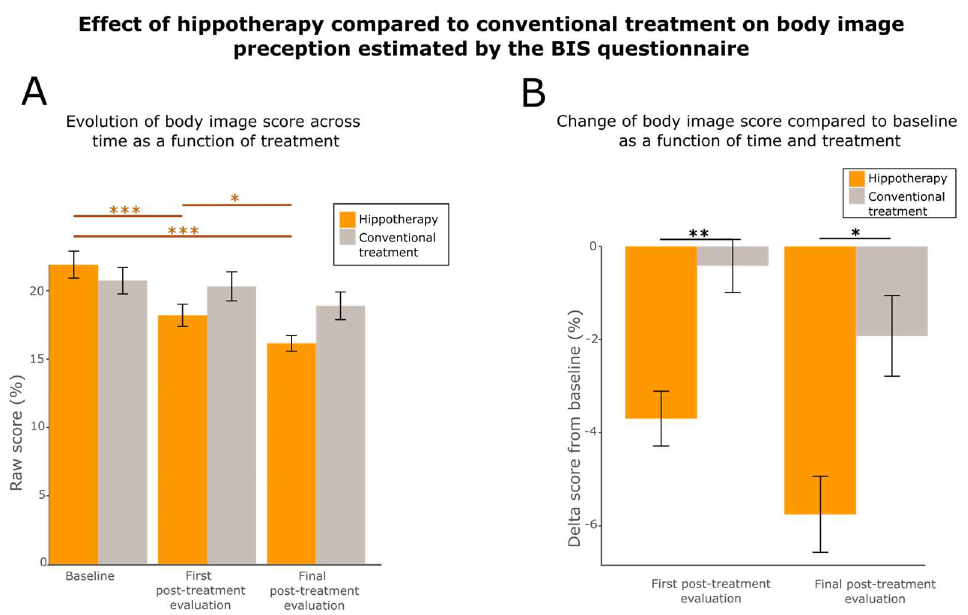
Figure 6. Effects of hippotherapy treatment compared to conventional treatment on body image per- ception, as estimated by the BIS questionnaire. ( A ) Bar chart represents means (M) and standard errors of means (SEM) for the evolution of body image score across time as a function of treatment’s type. Values (M ± SD) are as follows: Baseline = 21.9 ± 7.9, First post-treatment evaluation = 18.2 ± 6.41, Final post-treatment evaluation = 16.1 ± 4.65 for the hippotherapy group; Baseline = 20.7 ± 7.79, First post-treatment evaluation = 20.3 ± 8.48, Final post-treatment evaluation = 18.9 ± 8.04 for the control group. ( B ) Change in body image scores compared to baseline score (M ± SEM), as a function of time and treatment. Values (M ± SD) are as follows: First post-treatment evaluation = − 3.70 ± 4.71, Final post-treatment evaluation = − 5.74 ± 6.63 for the hippotherapy group; First post-treatment evaluation = − 0.4233 ± 4.57, Final post-treatment evaluation = − 1.83 ± 7.04 for the control group. (***) p < 0.001; (**) p < 0.01; (*) p <